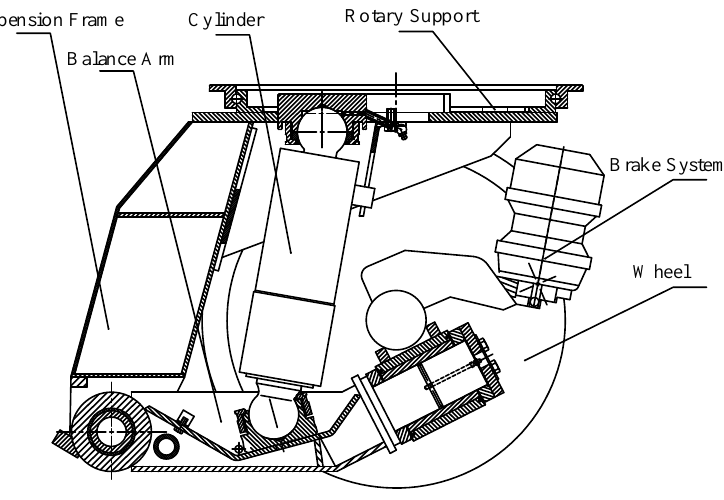
Figure 2. Schematic diagram of the suspension system.